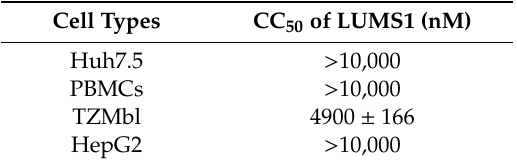
Figure 6. Evaluation of B cells activation by LUMS1 and its cytotoxicity: ( a ) graph presenting the flow cytometry analysis to determine the population of CD20 + cells in freshly isolated PBMCs. PBMCs were isolated from freshly collected blood using density gradient centrifugation and washed with PBS. After treating PBMCs (10 6 cells/mL) with varying concentrations of LUMS1 and MVN for 72 h at 37 °C and 5% CO 2 , cells were washed with PBS and incubated with percp cy5.5-conjugated anti-CD20 antibodies for 30 min at 4 °C. Finally, cells were washed with PBS (2% FBS), fixed with 1% formaldehyde and analyzed by FACS, using CellQuest software for data acquisition. Data were statistically analyzed using GraphPad Prism software. Analyses were performed in triplicate and one-way ANOVA with multiple comparisons was used to compare different groups. * p ≤ 0.05, ** p ≤ 0.01; *** p ≤ 0.001. ( b ) The plot showing concentration dependent cytotoxic effect of LUMS1 on PBMCs, HepG2, and TZM-bl cells. Table 2. Overview of the cytotoxicity of LUMS1 against different cell lines.